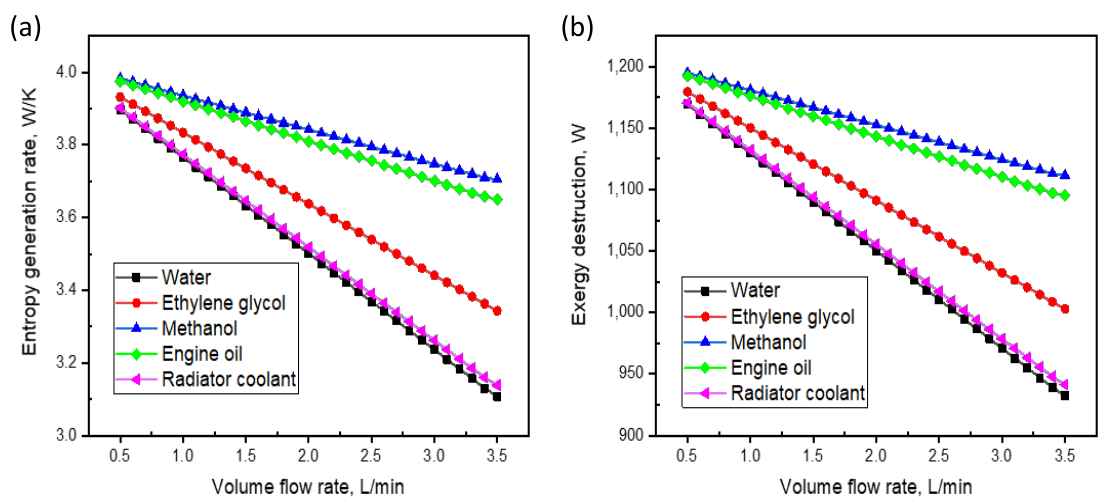
Figure 3. Variation of ( a ) entropy generation rate and ( b ) exergy destruction with a volume flow rate of nanofluids.